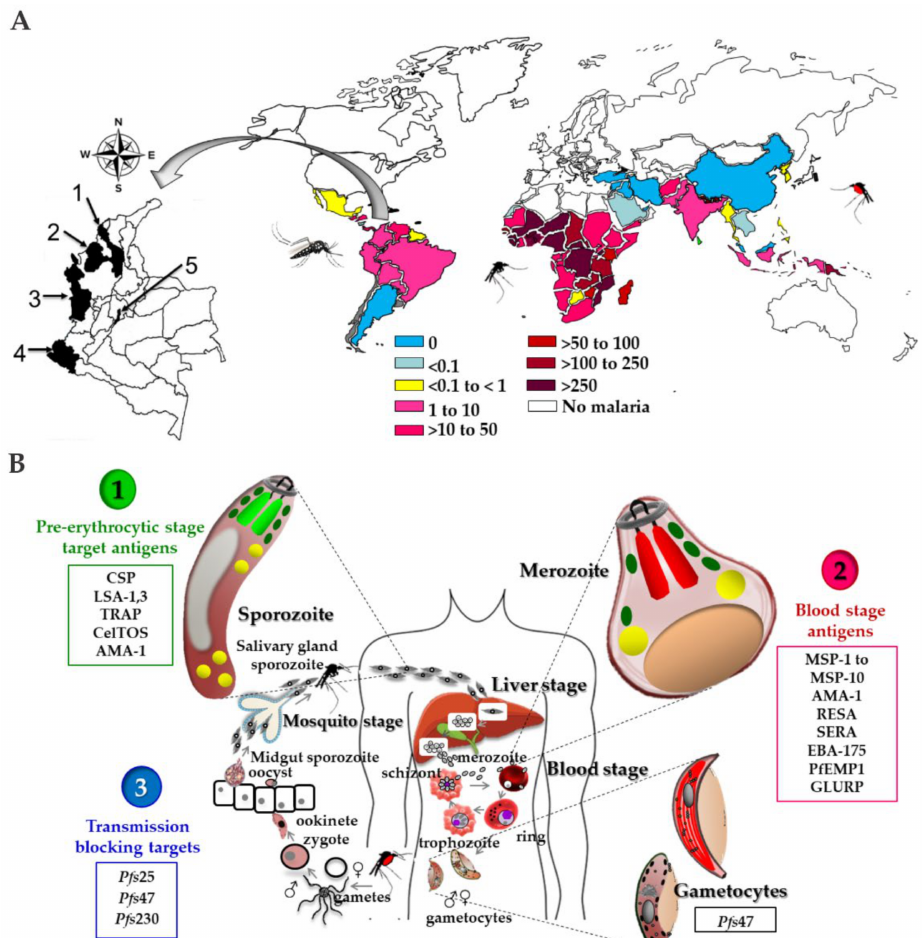
Figure 1. ( A ) Malaria incidence 2019 [1]. Selected villages and provinces of malaria endemic areas in Colombia are 1. San Juan de Nepomuceno (Bol í var), 2. Tierralta (C ó rdoba),3. Quibd ó (Choc ó ), 4. Tumaco (Nariño) and 5. Bogot á DC (non-endemic for malaria) ( B ) Plasmodium spp. life cycle and antigen targets for vaccine development are numbered from 1 to